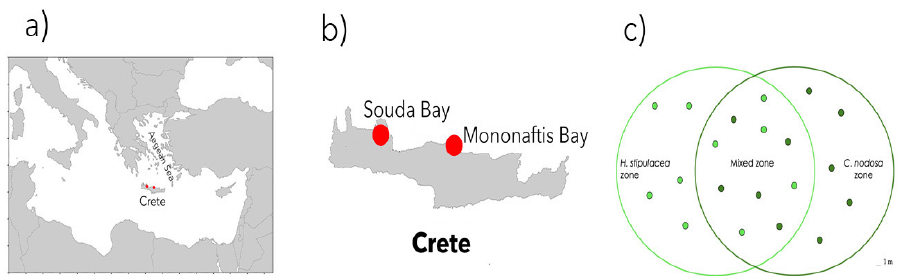
Figure 5. Sampling in the Crete Island ( a ); the sampling sites, Souda Bay and Mononaftis Bay ( b ); the sampling design, with randomly chosen sampling points ( c ).